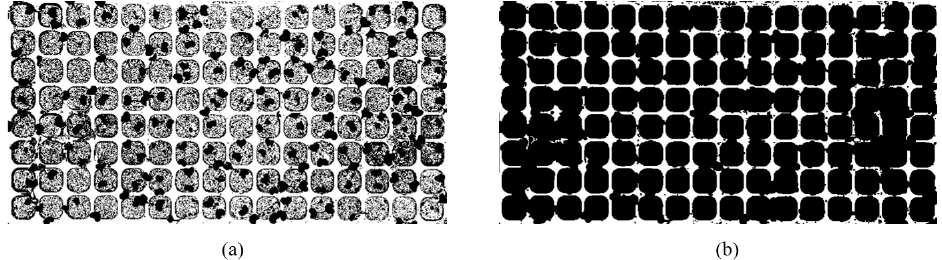
Figure 1. Threshold segmentation and borderline binarization: ( a ) tray threshold segmentation and ( b ) tray binarization.